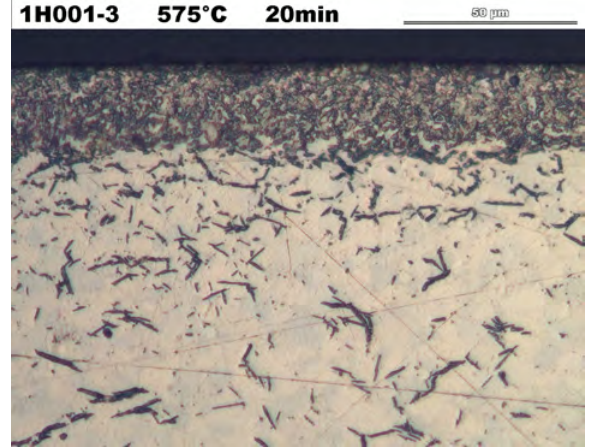
Figure 9. Sample 1H001, section 3. After hydrogen charging was used annealing at temperature 575 ◦ C and 20 minutes of time duration.